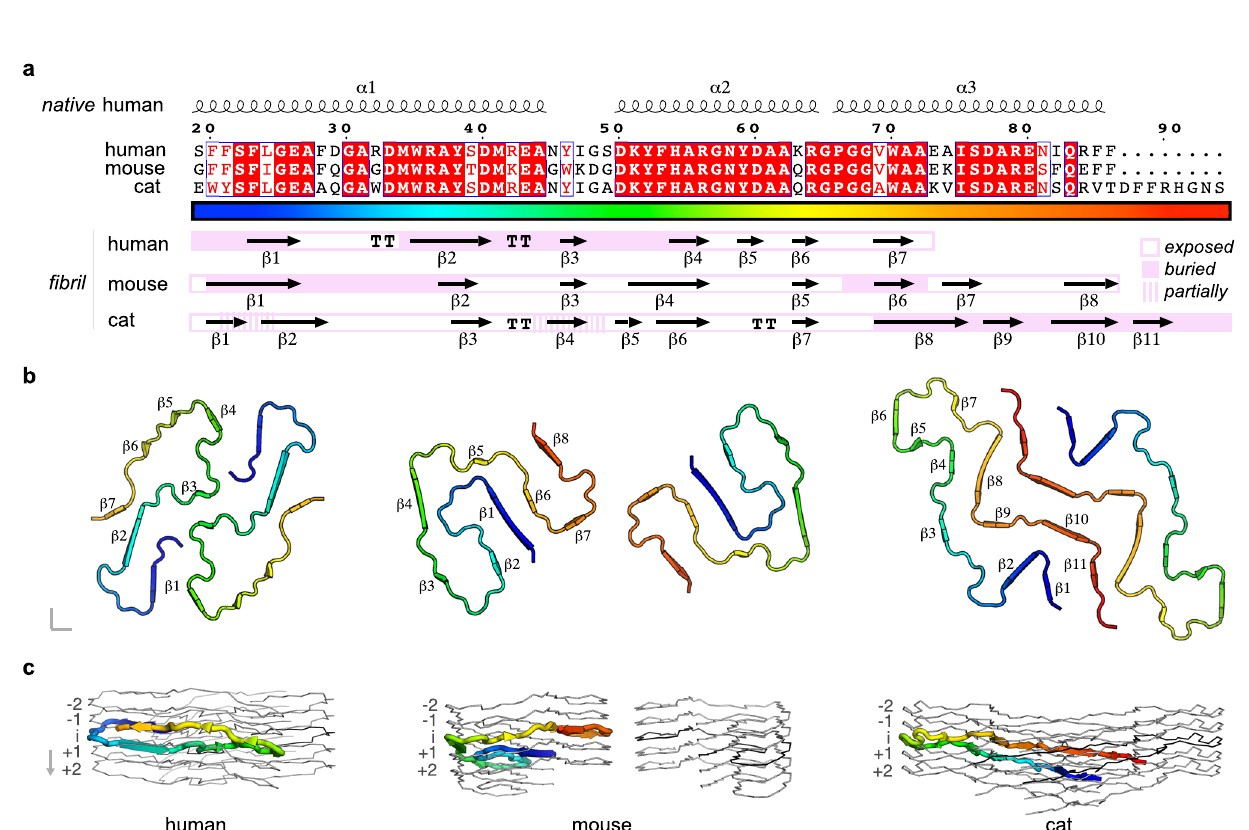
bondaswellasioniccontactsareshownasyellowandpinksemi-transparentheavy lines.The backbone and side chain atoms of the opposing strandsare represented in mixed cartoon/stick format in white with black outlines. Residue contacts atthe inter-protomer interface are related by a two-fold symmetry axis, which is high- lighted by black and gray residue labels. See Supplementary Fig. 6 for molecular footprints to illustrate staggered contacts.